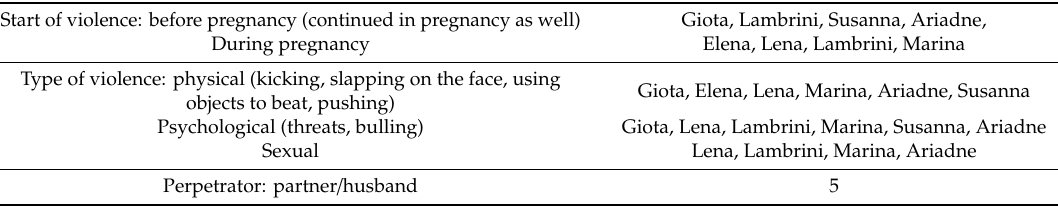
Table 2. Characteristics of